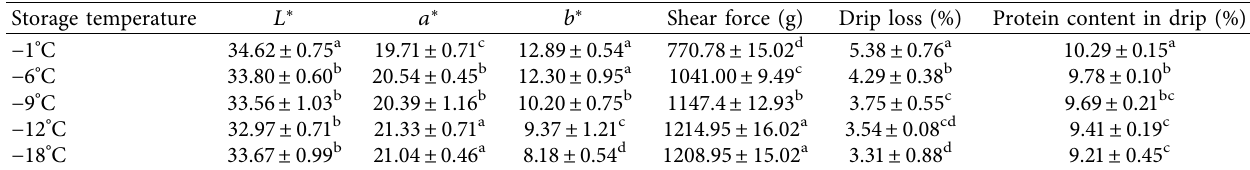
Table 3: Quality properties of beef after frozen at − 1 ° C (for 28 days), − 6 ° C (for 84 days), − 9 ° C (for 126 days), − 12 ° C (for 168 days), and − 18 ° C (for 168